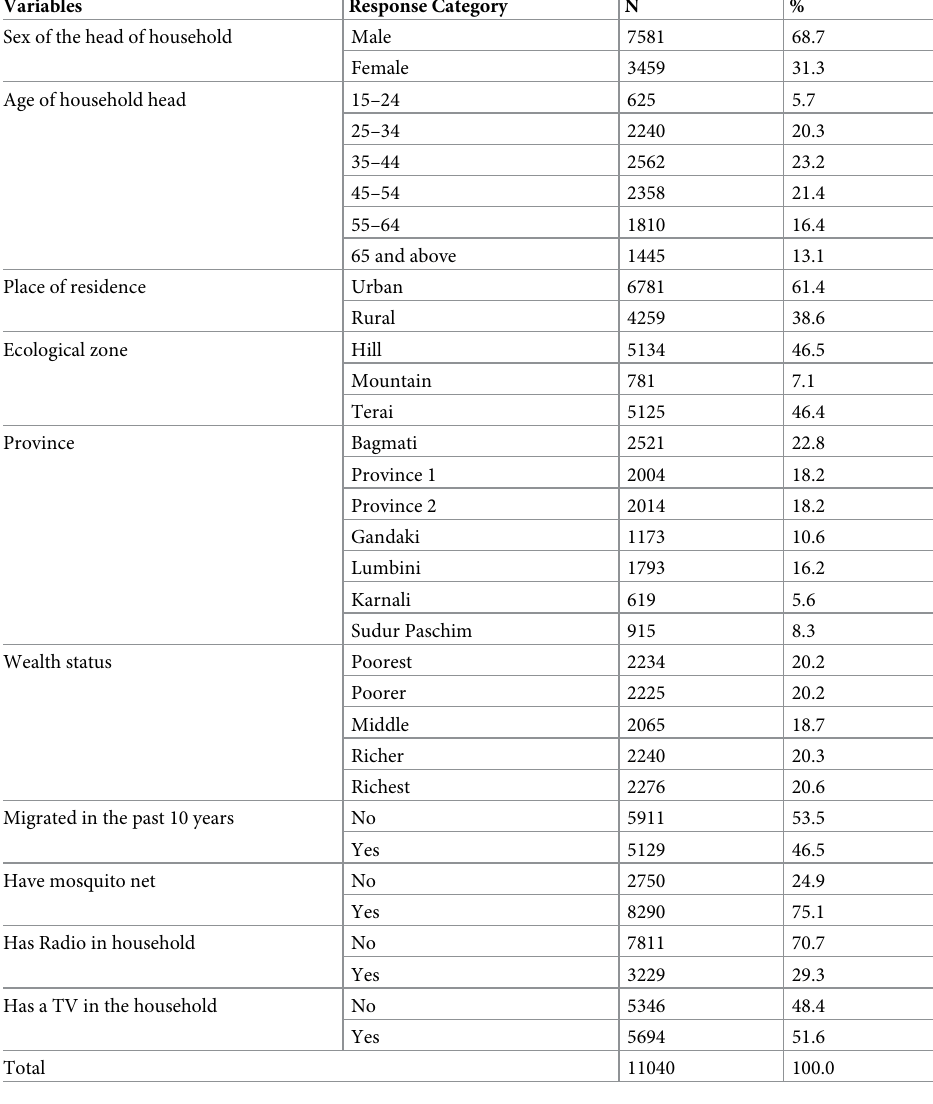
Table 1. Background characteristics of respondents (head of